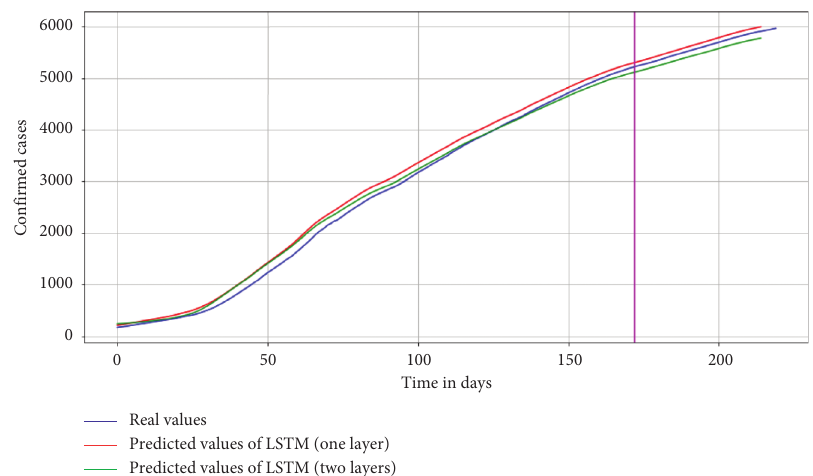
Figure 8: Comparison between real death cases and the predicted death cases for LSTM (Saudi Arabia).